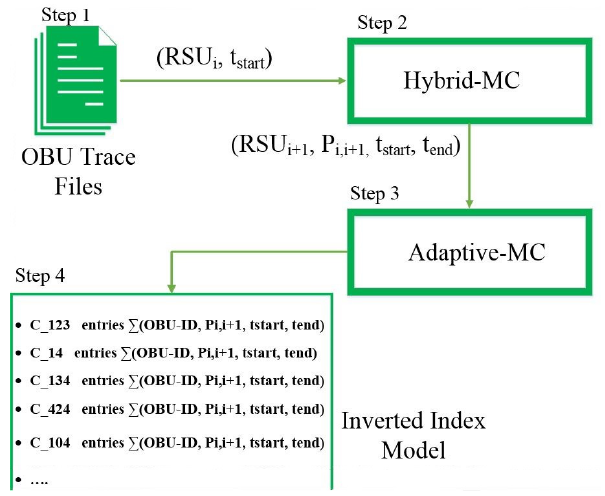
Figure 4. Vehicle trajectory density